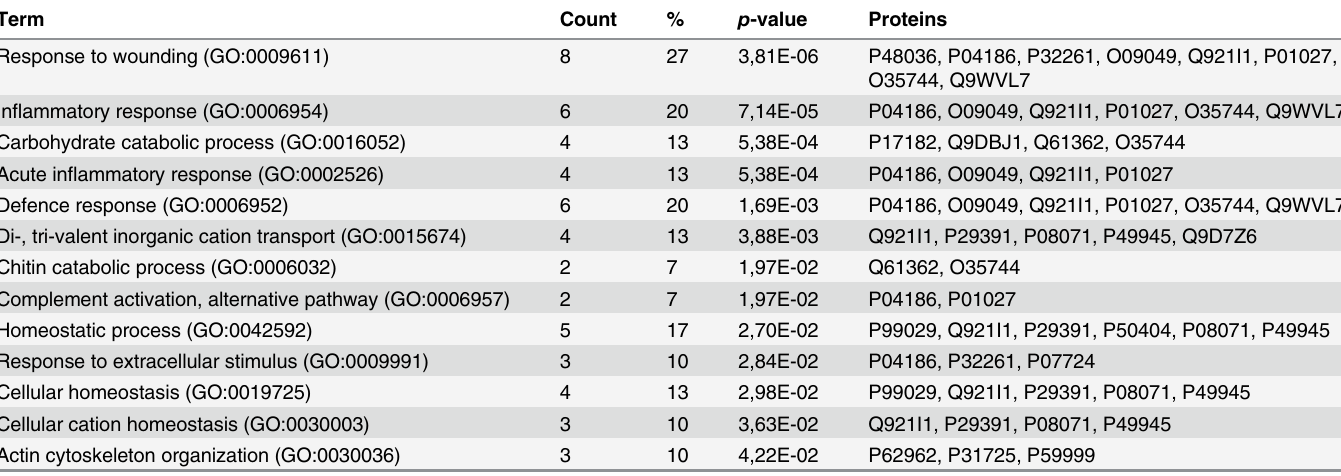
Table 2. Functional